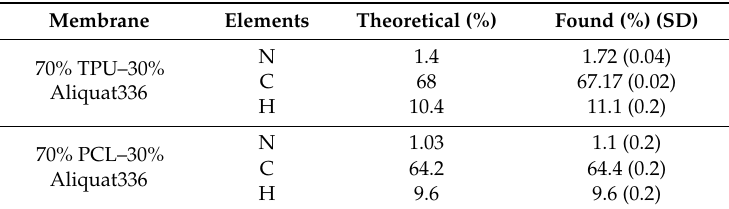
Table 2. Mass concentration of the characteristic elements of the PIM, presented as the average values percentages (n =